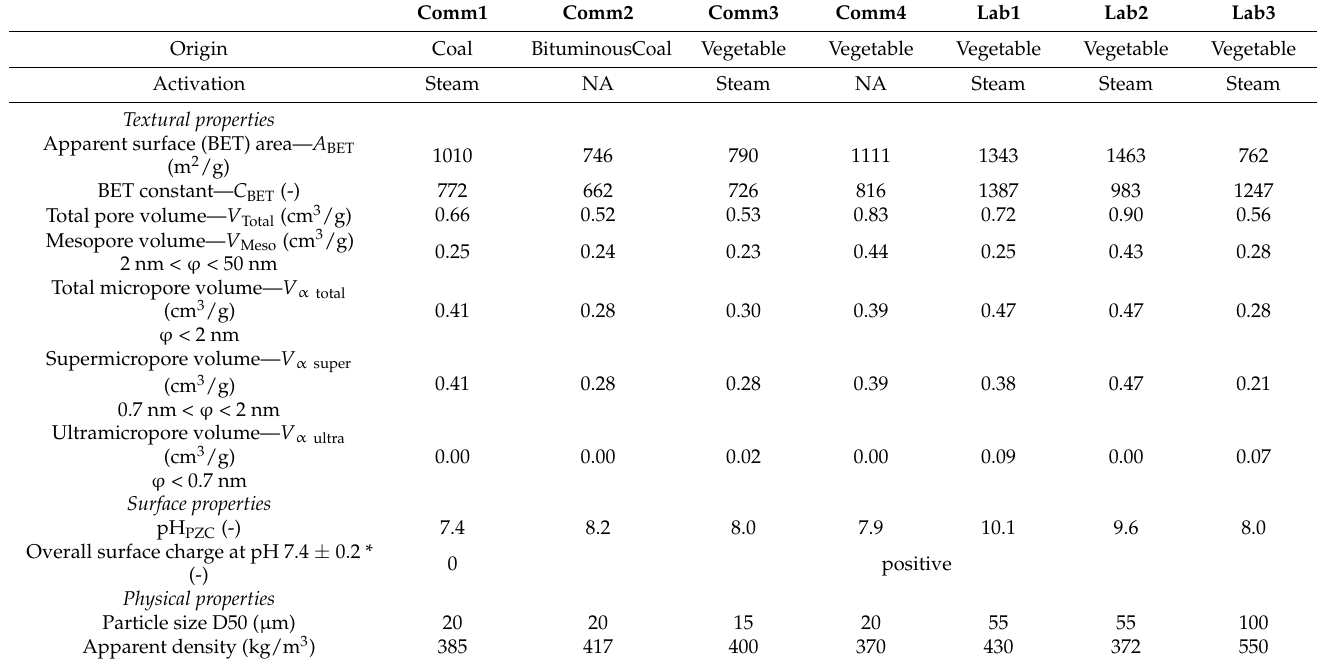
Table 4. Textural, surface and physical properties of the commercial and lab-made